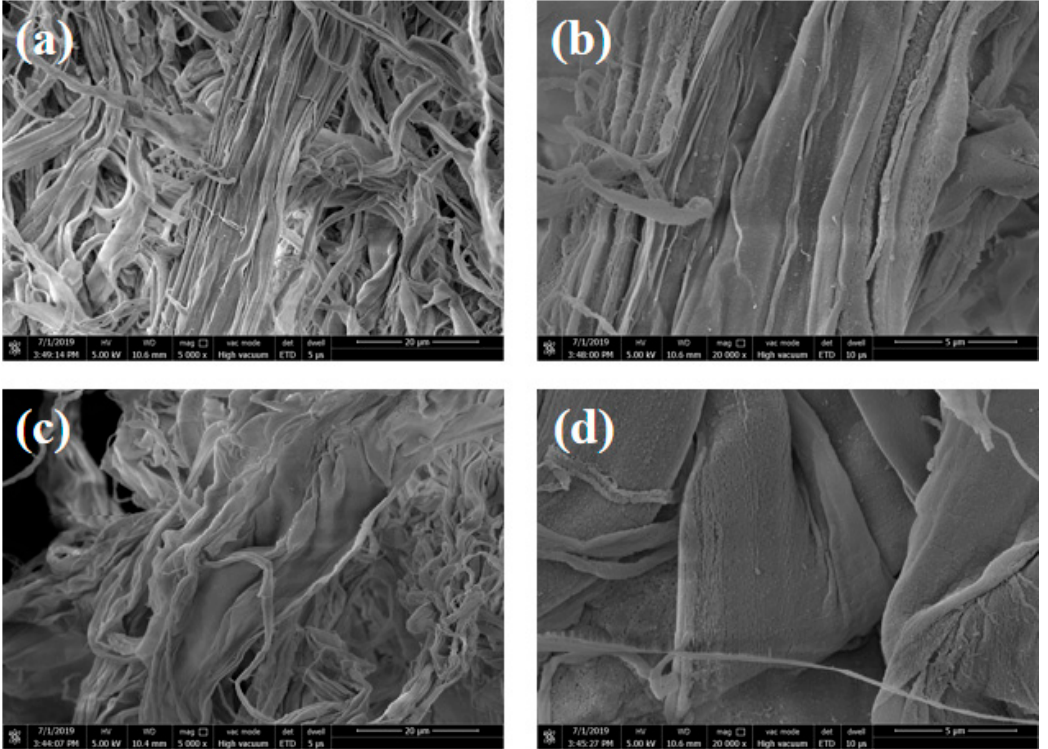
Figure 1. SEM images of original and modified fibrids; ( a , b ) meta-aramid fibrids (MAF), and ( c , d ) chlorinated MAF (MAFC).